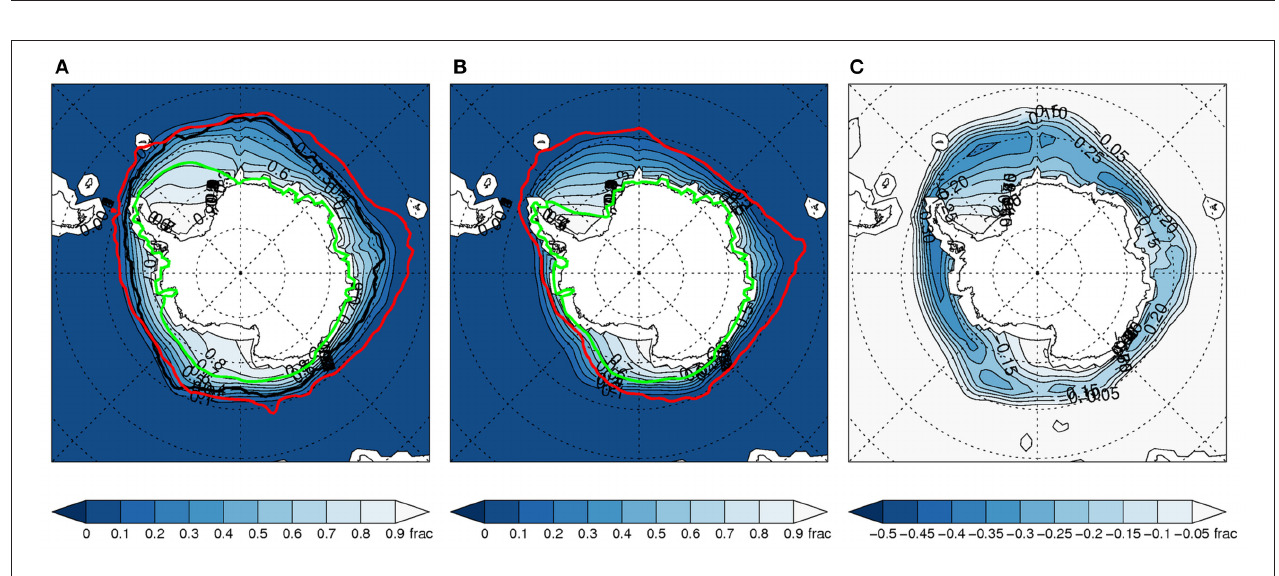
FIGURE 1 | Austral summer (DJF) sea ice distribution for all available 35 models from historical simulations over the period 1979-1999 (A) and RCP8.5 (2079-2099) (B) and the RCP8.5-historical difference (C) . On each plot the filled contours show the all-model ensemble mean sea ice concentration, the red lines show the ice edge for the model with most ice and the green lines show the ice edge for the model with least ice. The black lines on (A) show the observed extent (for 1979-1999 period) from the Comiso Bootstrap 2 dataset (see Materials and